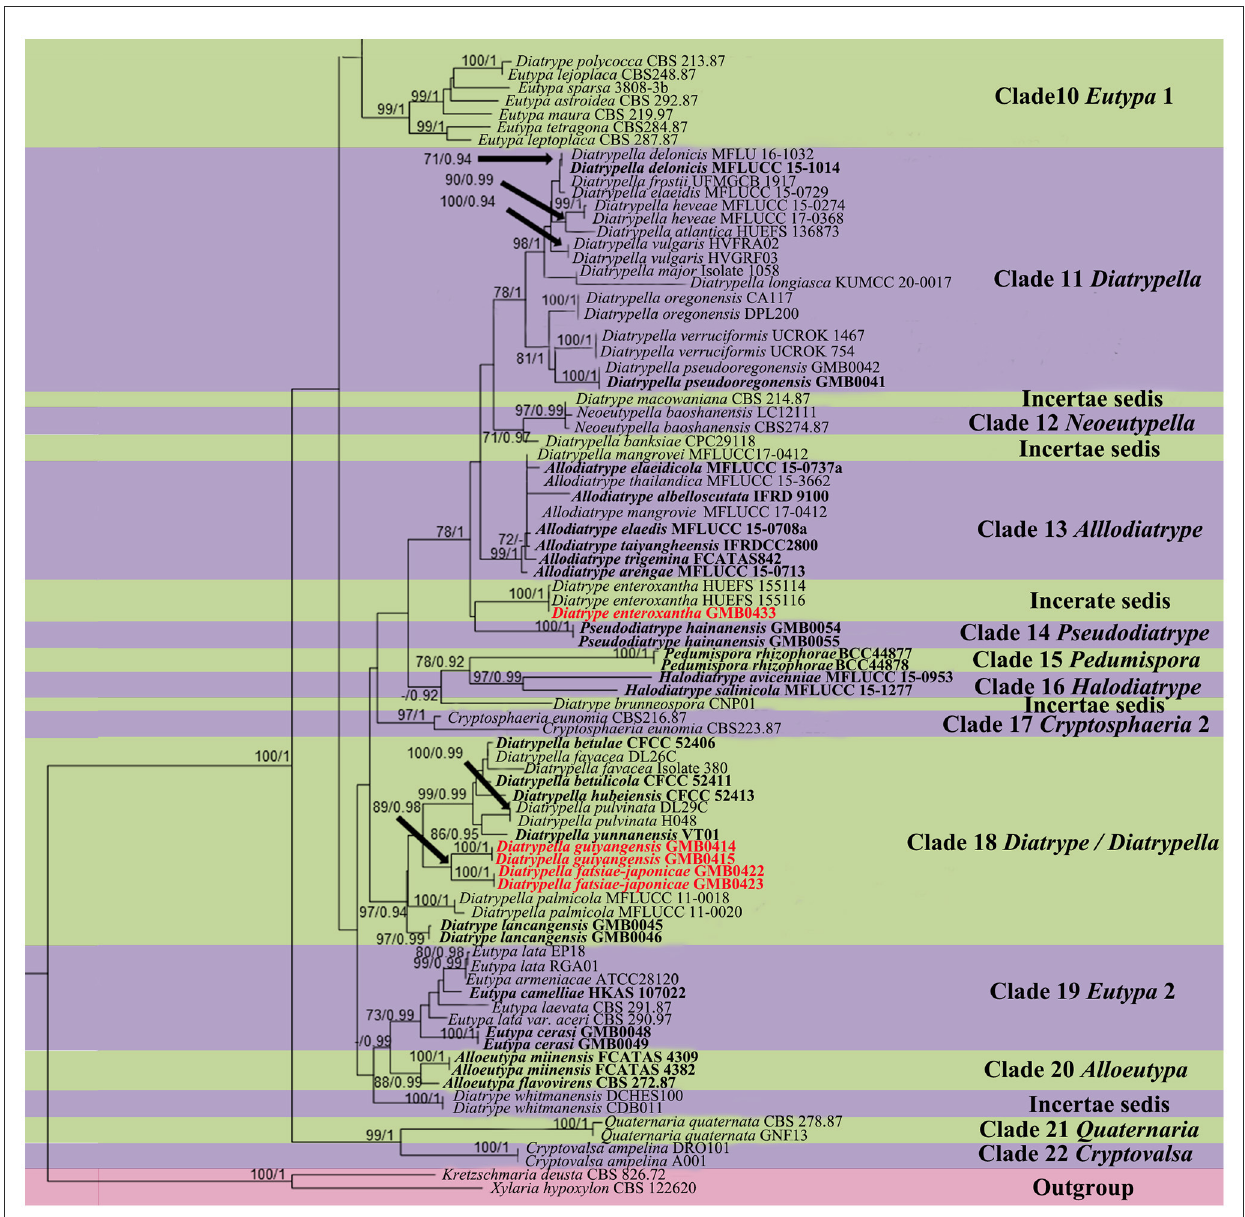
Ex-type strains are in black bold. Newly generated strains are in red bold.